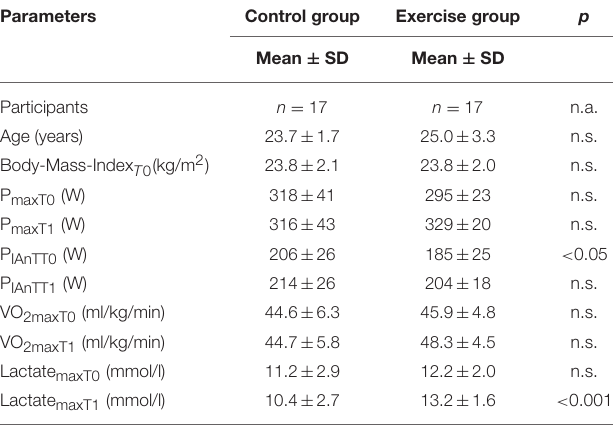
TABLE 1 | Epidemiological data of participants.